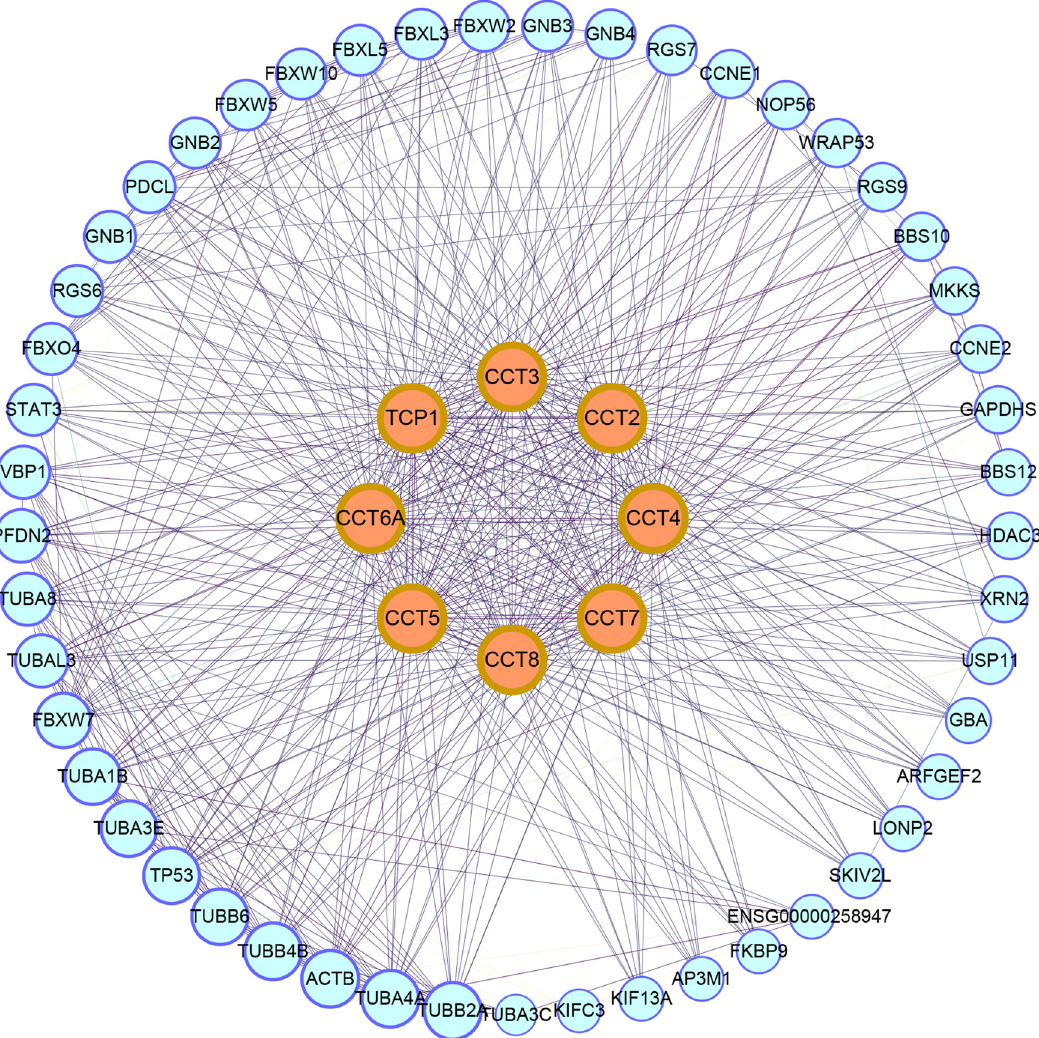
Figure 8: Protein – protein interaction ( PPI ) network. The PPI network of CCTs and 50 most frequently altered neighbor genes, which includes 58 nodes and 591 edges ( PPI enrichment P value < 1.0 × 10 − 16 ) , visualized by Cytoscape